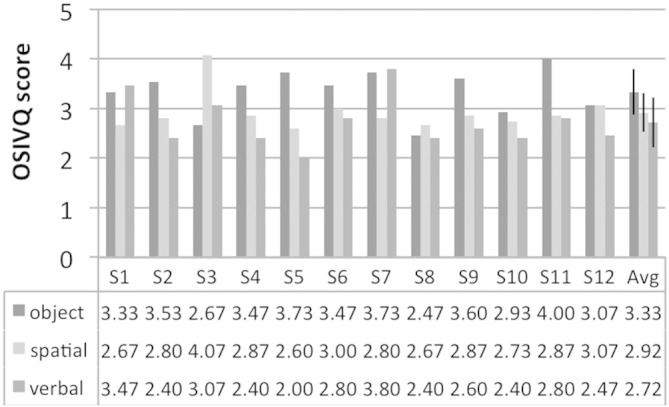
Object-Spatial Imagery and Verbal Questionnaire (OSIVQ) scores. OSIVQ scores for the three different scales “object”, “spatial”, and “verbal” are shown for all subjects (S1 through S12). The last column shows the group averages (Avg); error bars indicate one standard deviation.